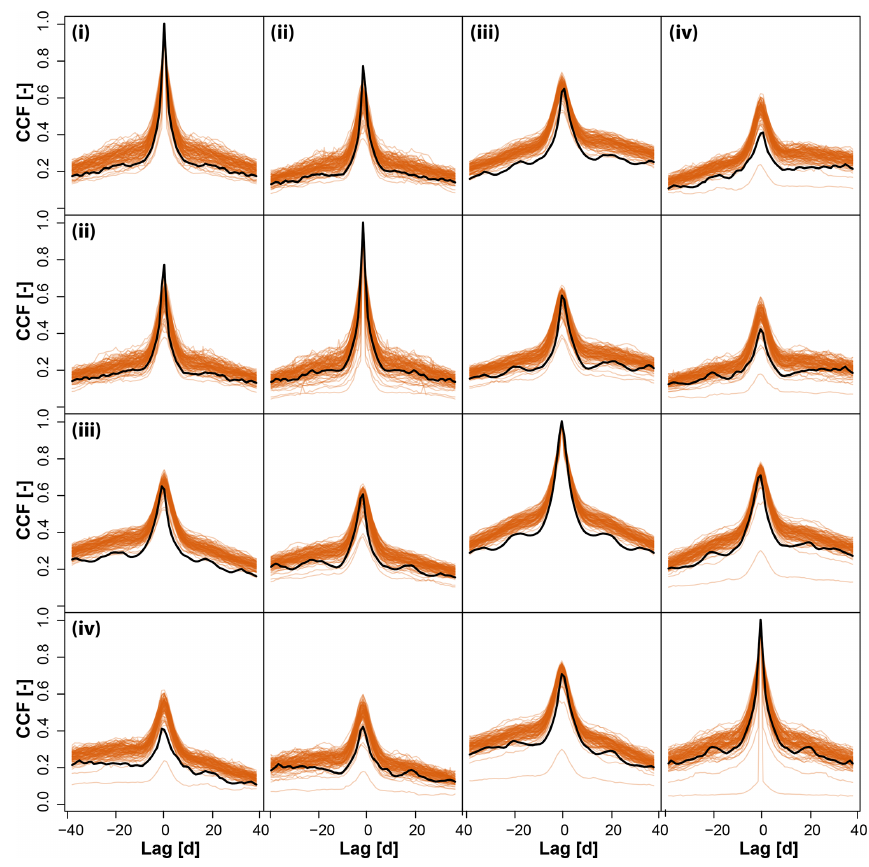
Figure 7. Comparison of observed (black) and simulated (orange) cross-correlation functions (ccfs) for the daily discharge values for pairs of stations in the set of four catchments (i–iv) in the Pacific Northwest.